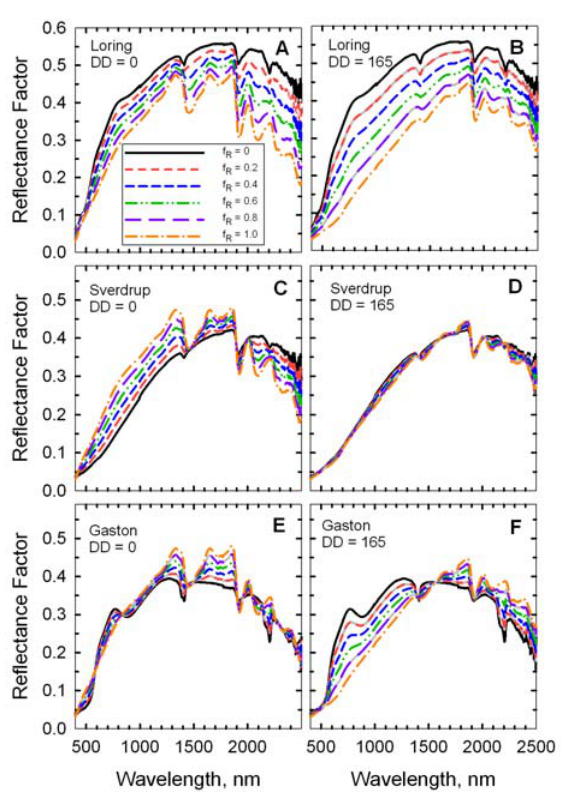
Figure 7. Reflectance spectra of simulated scenes with mixtures of two wheat residues (DD = 0 and DD = 165) on three soils. The fraction residue cover (f (100% soil) to 1.0 (100% wheat